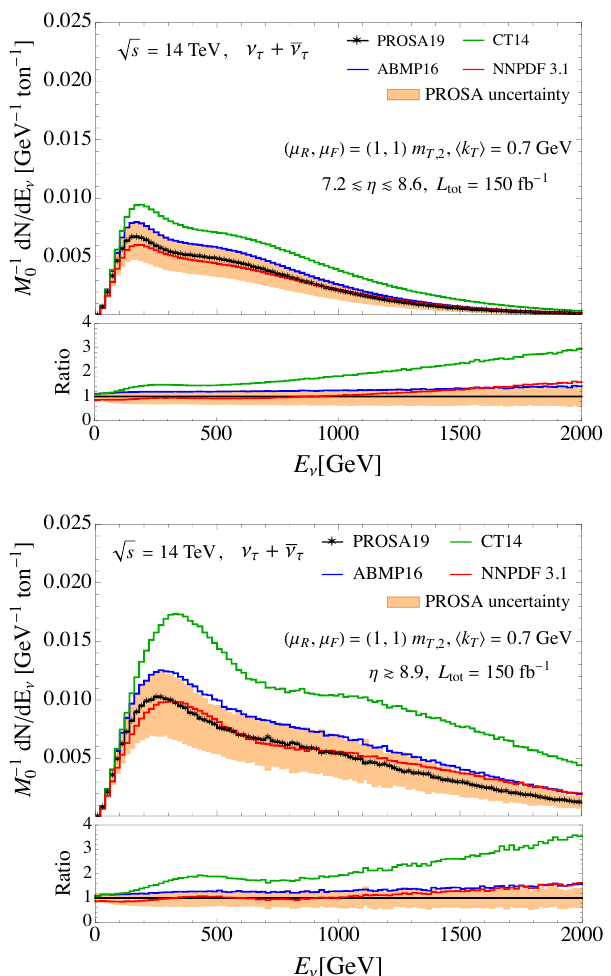
Figure 19. The energy distribution of tau neutrino and antineutrino charged-current events per ton at a distance D d = 480 m from the collider interaction point, obtained with PDF sets by different collaborations, ABMP16 [34], CT14 [33], NNPDF3.1 [32] and PROSA FFNS. The uncertainty band accounts for PDF uncertainties computed with the PROSA PDFs. The predictions refer to the pseudorapidity ranges 7 . 2 < η ν < 8 . 6 (upper) and η ν > 8 . 9 (lower). The corresponding ratios to the central predictions of energy distributions of charged-current event numbers with PROSA uncertainty bands and with alternative PDFs are shown in the ratio